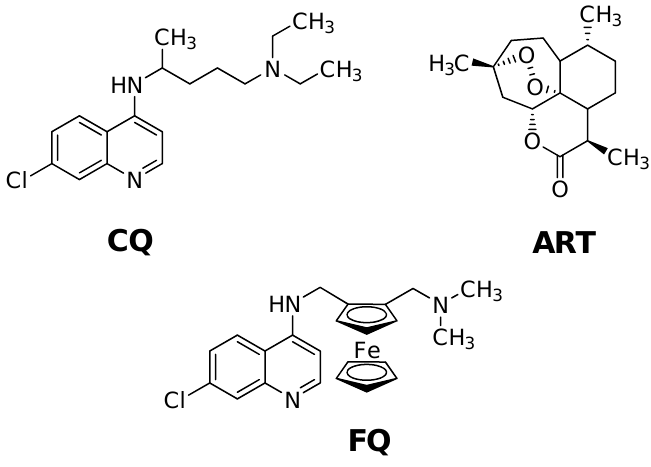
Figure 1. Chemical structures of chloroquine (CQ), artemisinin (ART) and ferroquine